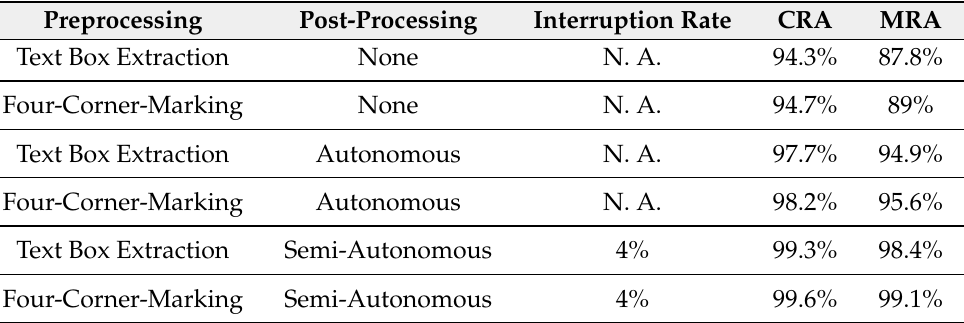
Table 3. Character Recognition Accuracy (CRA), Move Recognition Accuracy (MRA), and Interrup- tion Rate are for various levels of pre and